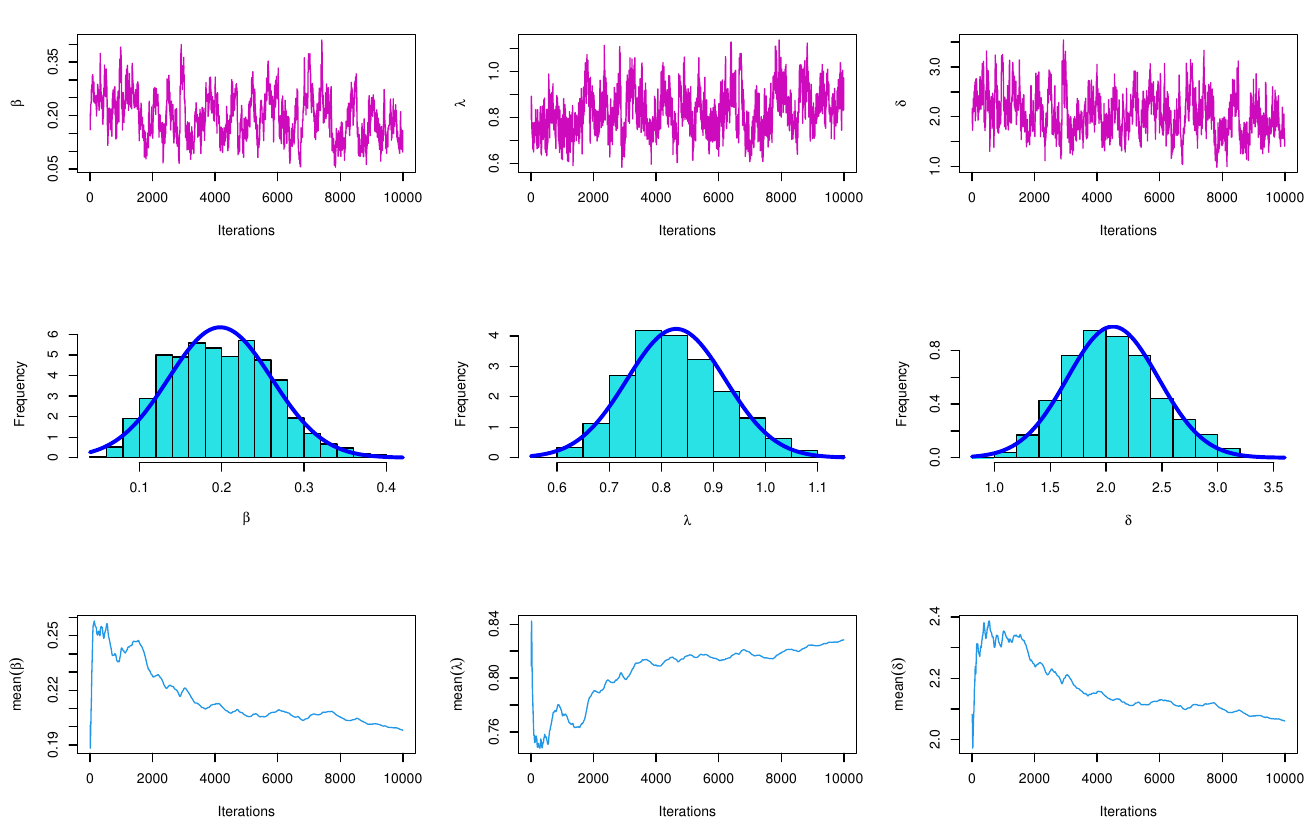
Figure 3. Convergence plots of MCMC for parameter estimates of TIIHLW distribution.